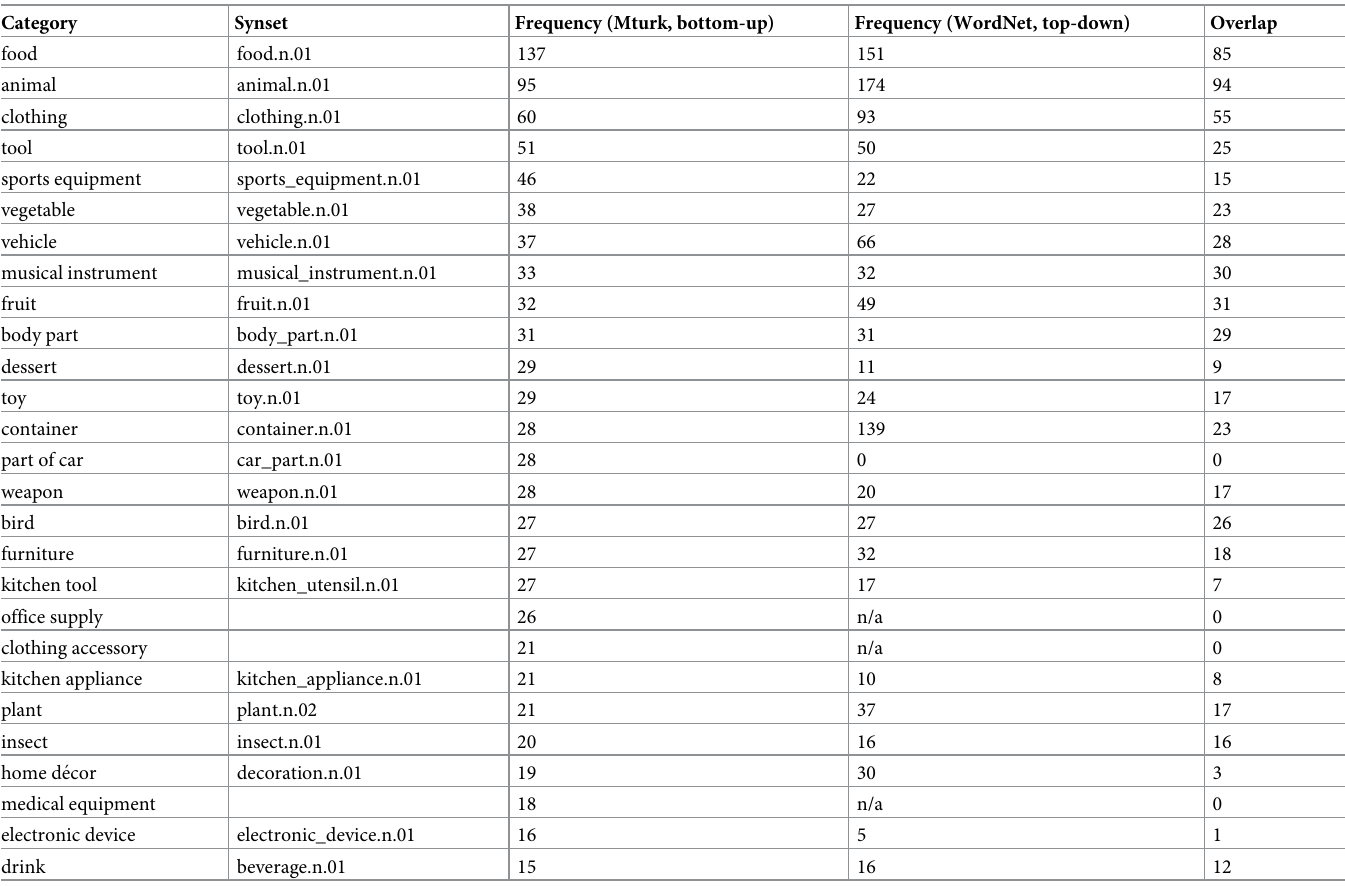
Table 1. High-level object categories based on object concepts in THINGS